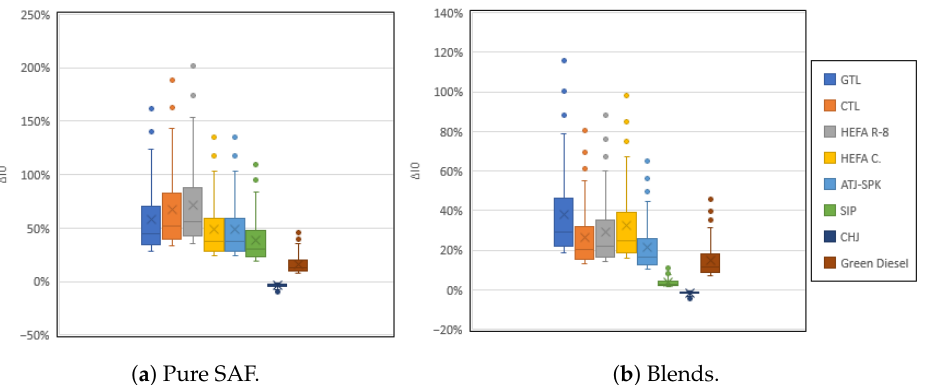
Figure 15. RDs in initial ice mass ratios for ambient relative humidities at formation in the range of 41% to 43%.